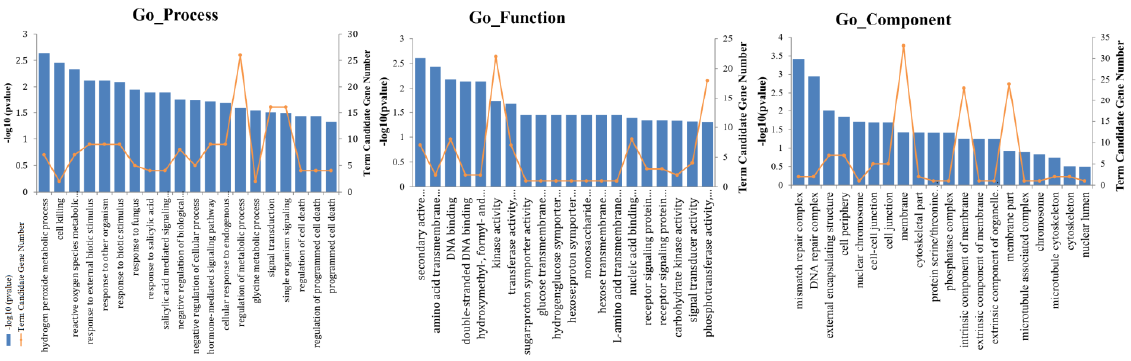
Figure 6. GO enrichment of 943 genes differentially expressed specifically in the Ont7813 response process.